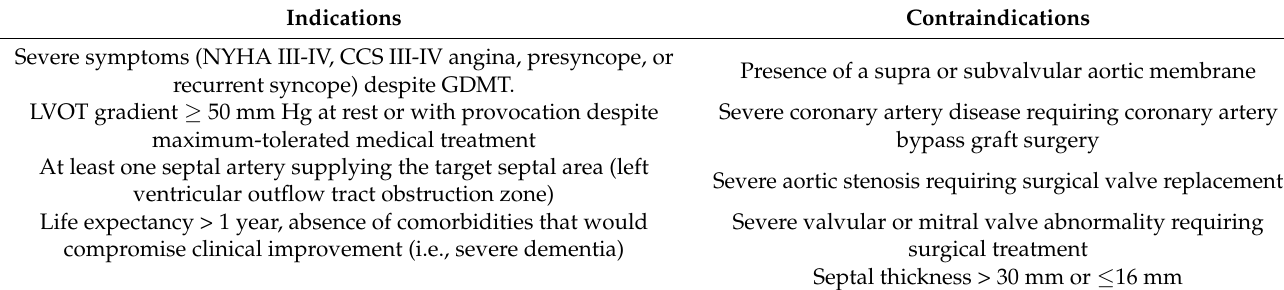
Table 2. ASA: indications and